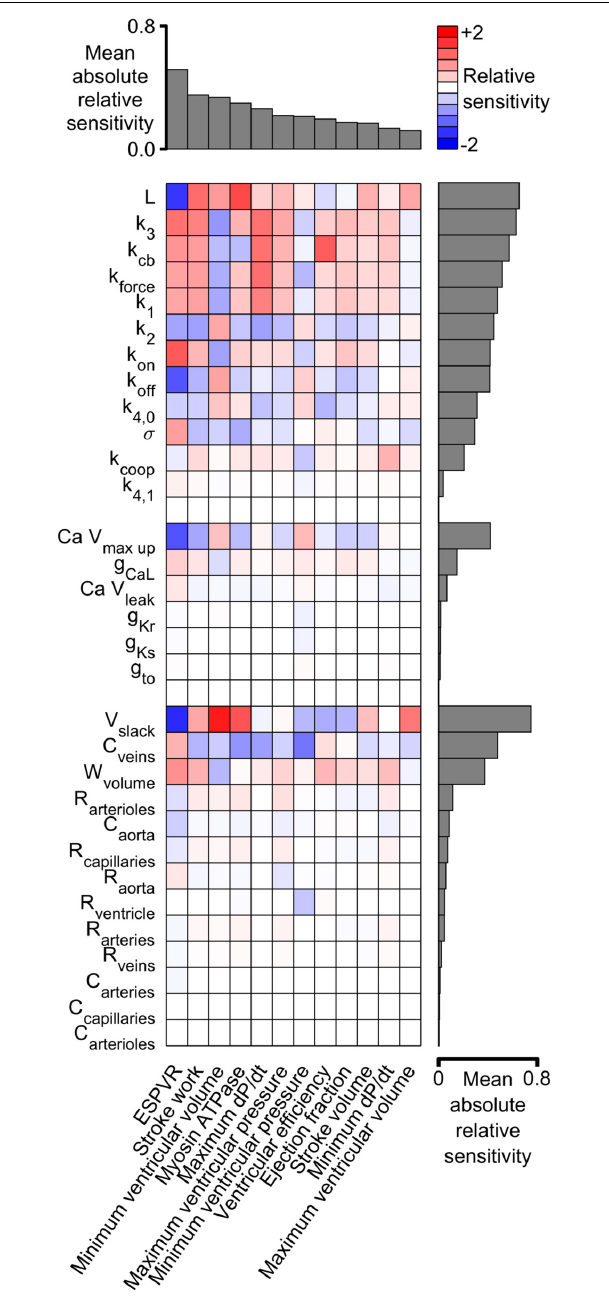
FIGURE 6 | Relative sensitivities for each combination of system-level property and model parameter. Red colors show property / parameter combinations that were positively correlated for small changes in the base parameter value. For example, stroke work, minimum ventricular pressure, and myosin ATPase all increased as L became larger (red boxes in columns 2–4 of the top row and Supplementary Figure S5 ). Blue colors show negative correlations. For example, ESPVR decreased as L became larger (blue box in column 1 of top row). The gray bars above the matrix show the mean of the absolute relative sensitivity values for each system-level property. The bars on the right show the corresponding means for each model parameter. The model parameters are clustered in three groups corresponding to the sarcomeric, electrophysiological, and circulatory levels of the